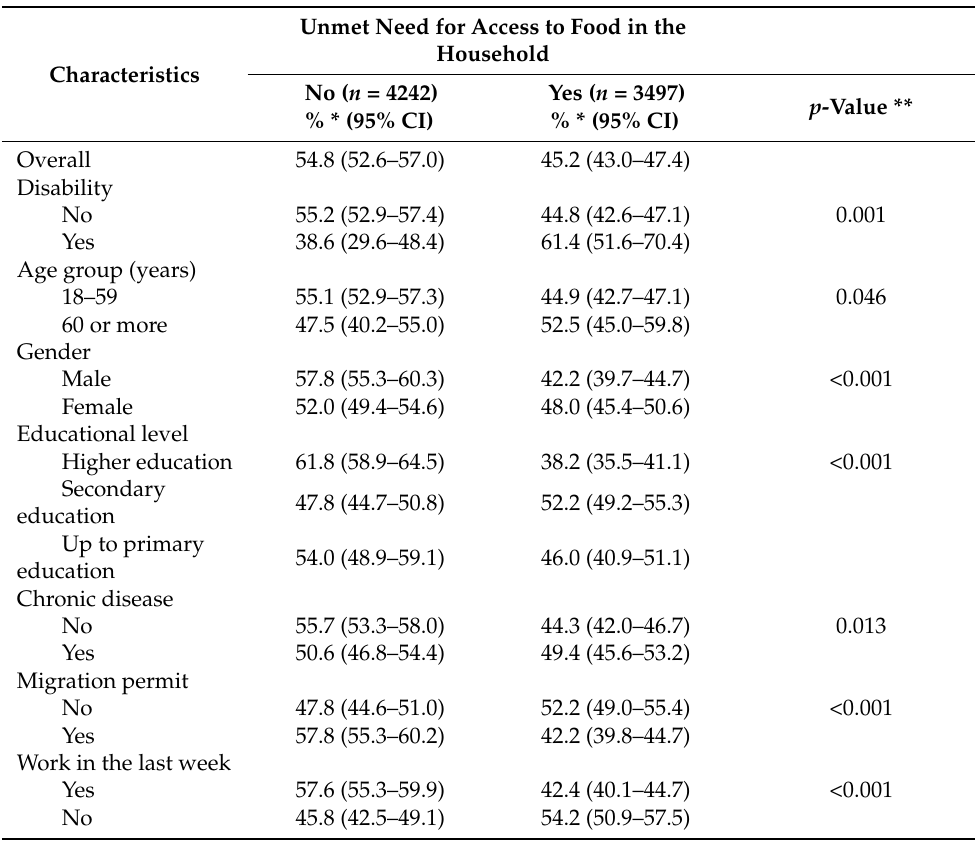
Table 2. Frequency of unmet need for access to food in the household among Venezuelan migrants and refugees by background characteristics, ENPOVE